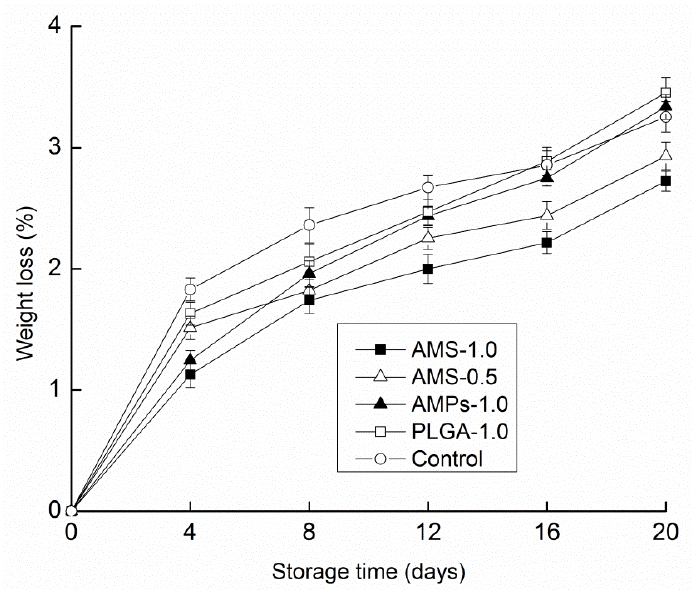
Figure 3. Effect of different antimicrobial coating on weight loss changes of Tricholoma matsutake stored at 4 ± 1 °C for 20 days. Each data point is the mean of three replicate samples.